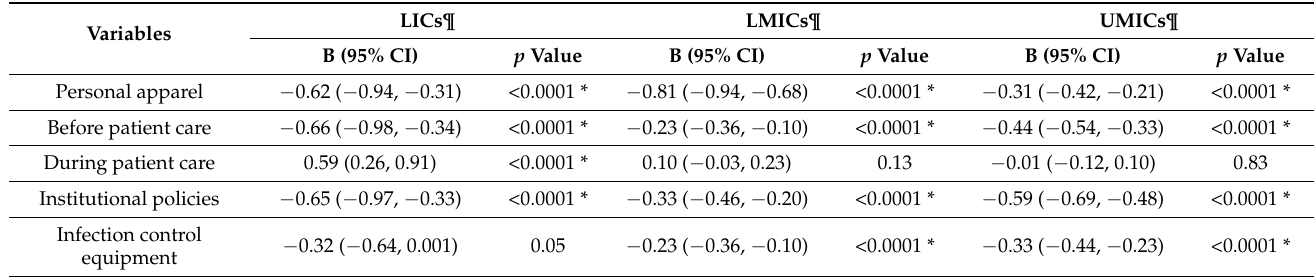
Table 4. Association between country level income and components of perceived preparedness reported by dental academics in dental academic institutions, using